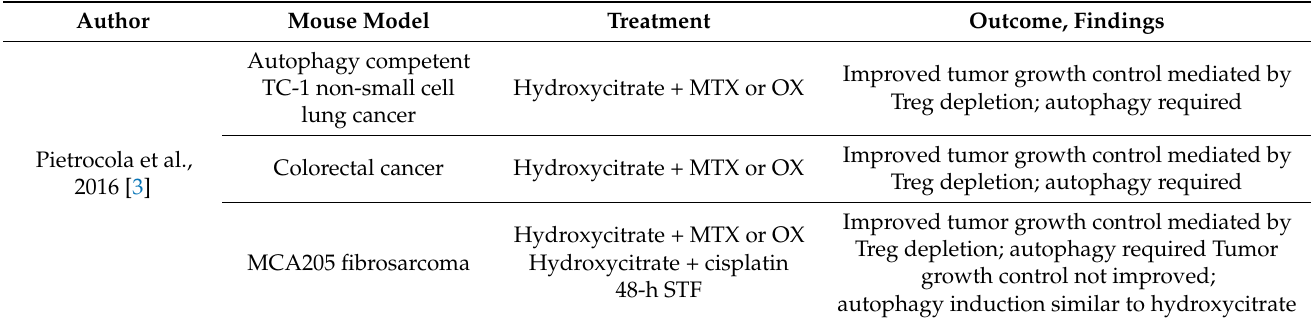
Table 1. Overview of preclinical studies in vivo reporting immunomodulatory effects of STF in the context of cancer